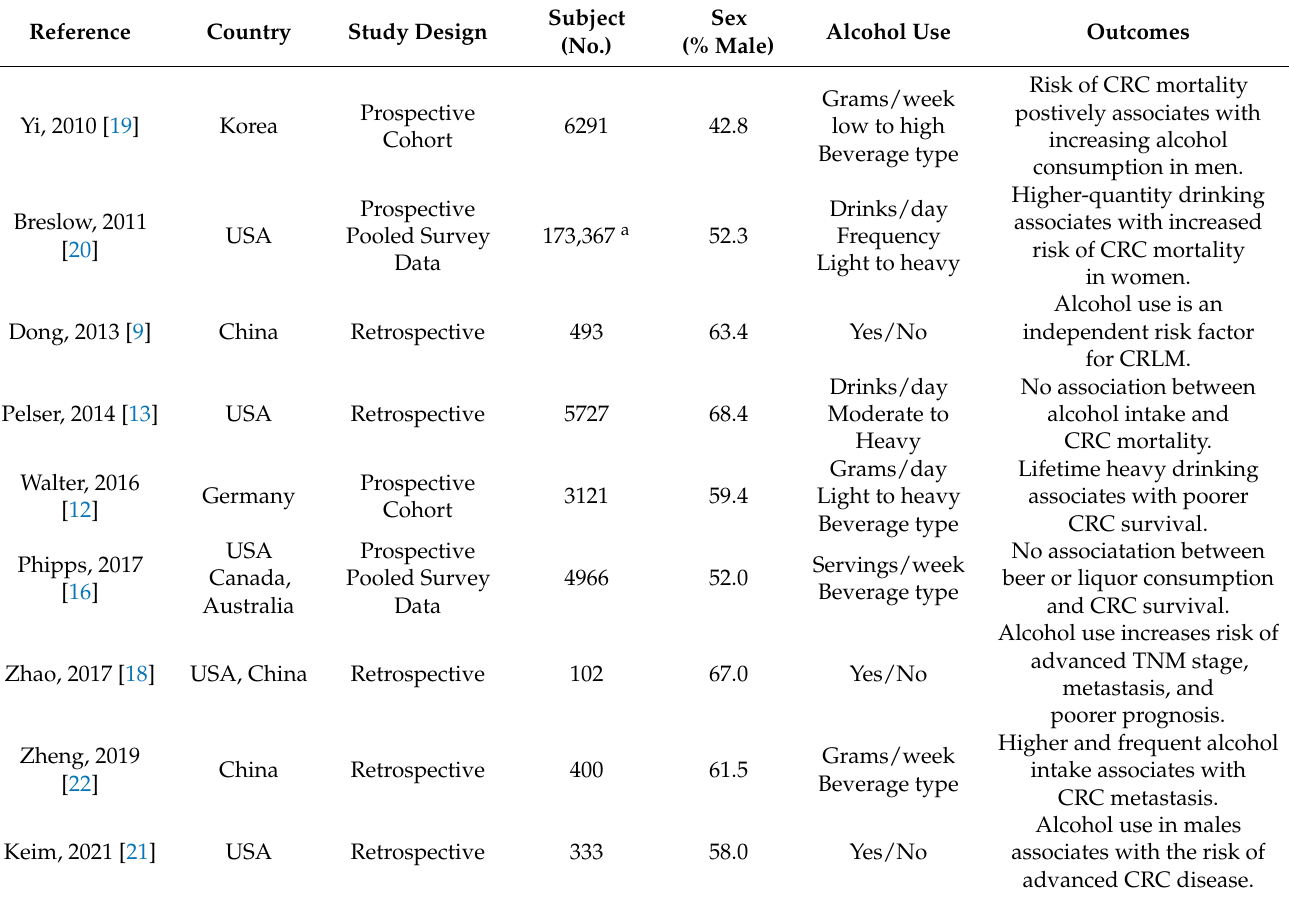
Table 2. Characteristics of included clinical studies.